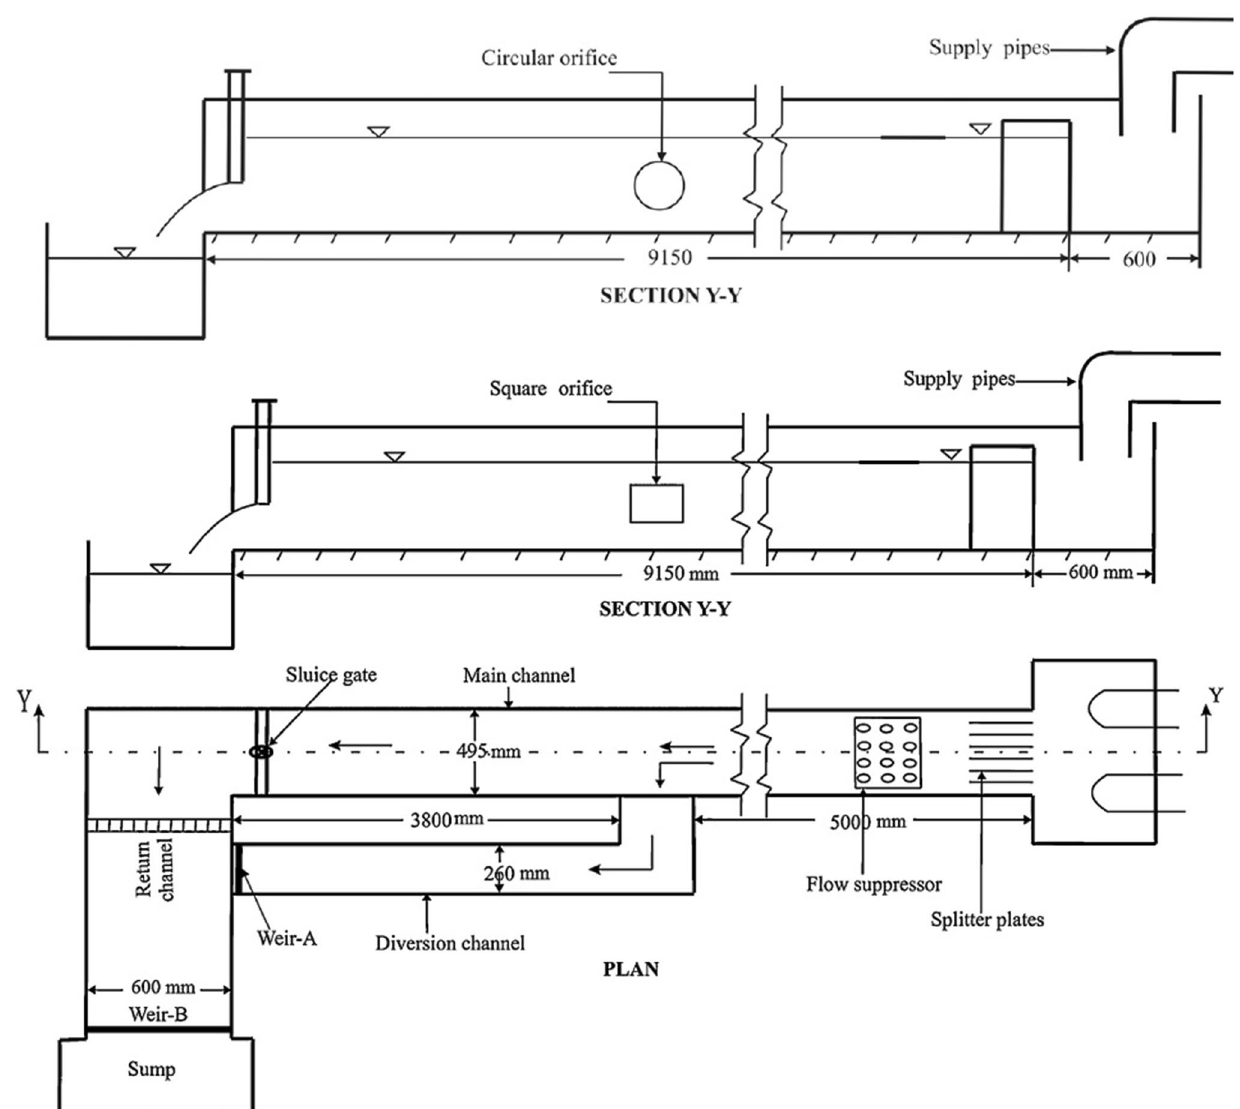
Fig. 3 Schematic of experimental model for rectangular and circular side orifices (Hussein et al. 2010 and Hussein et al.